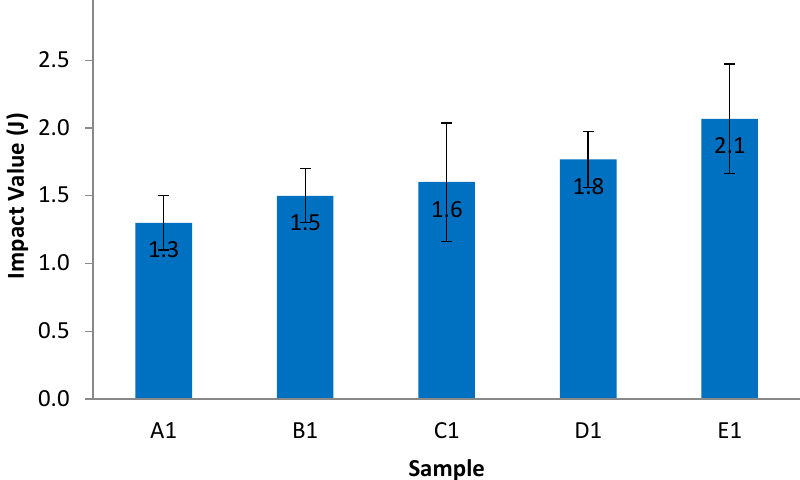
Figure 8. The results of impact testing on natural composite materials reinforced with sago midrib